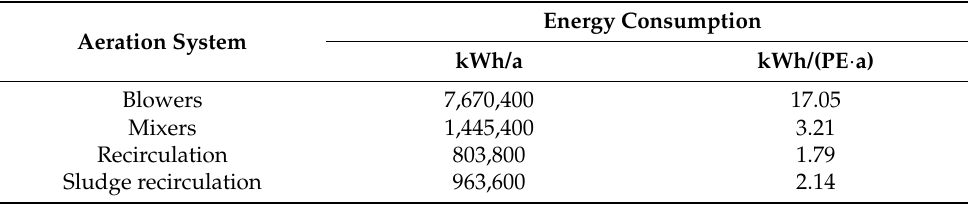
Table 5. Energy consumption for the biological treatment system of the example